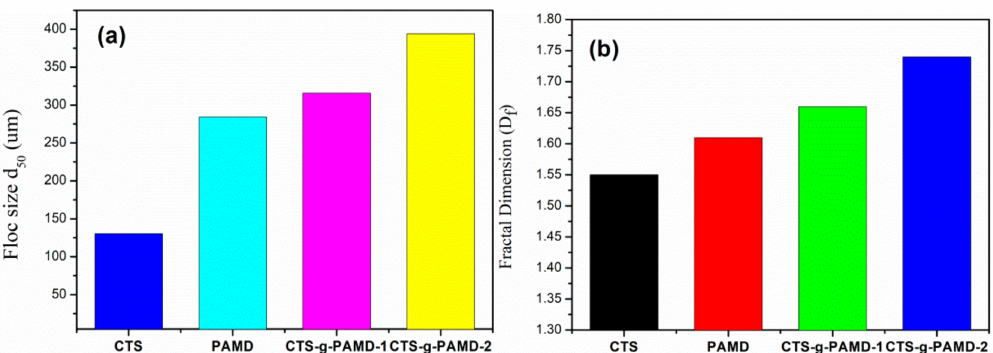
Figure 10. ( a ) Floc size d 50 and ( b ) floc D f for the